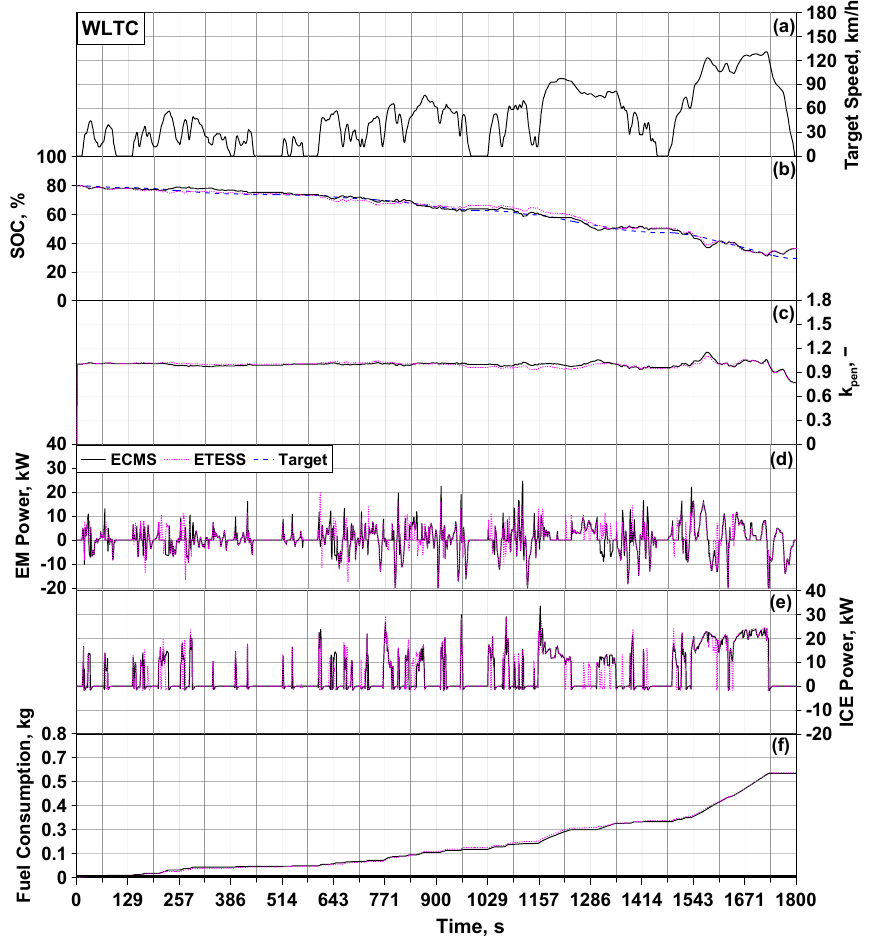
Figure 13. WLTC, ( a ) target speed. ETESS/ECMS comparisons of battery SoC ( b ), k pen ( c ), EM power ( d ), ICE power ( e ), and cumulated consumed fuel ( f ).